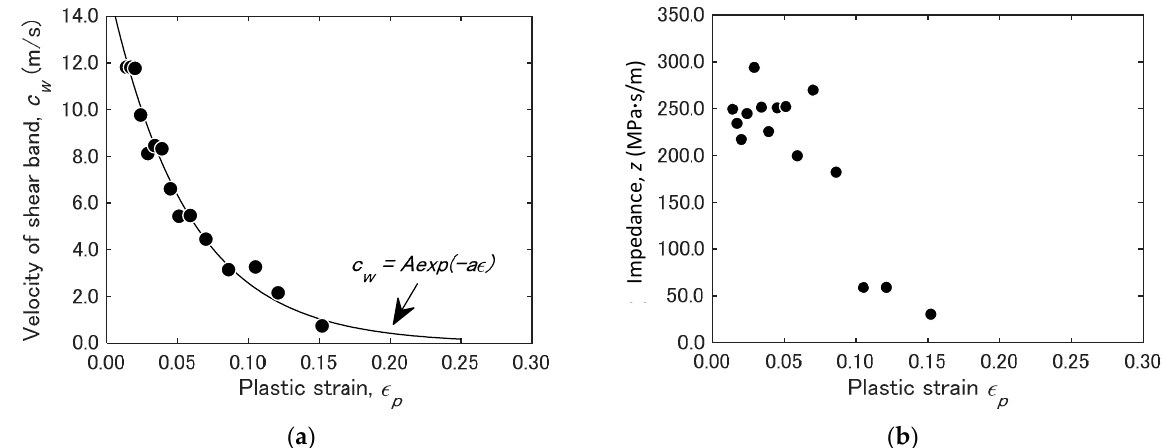
Figure 13. Velocity and impedance of shear band in 7075-annealed alloy.